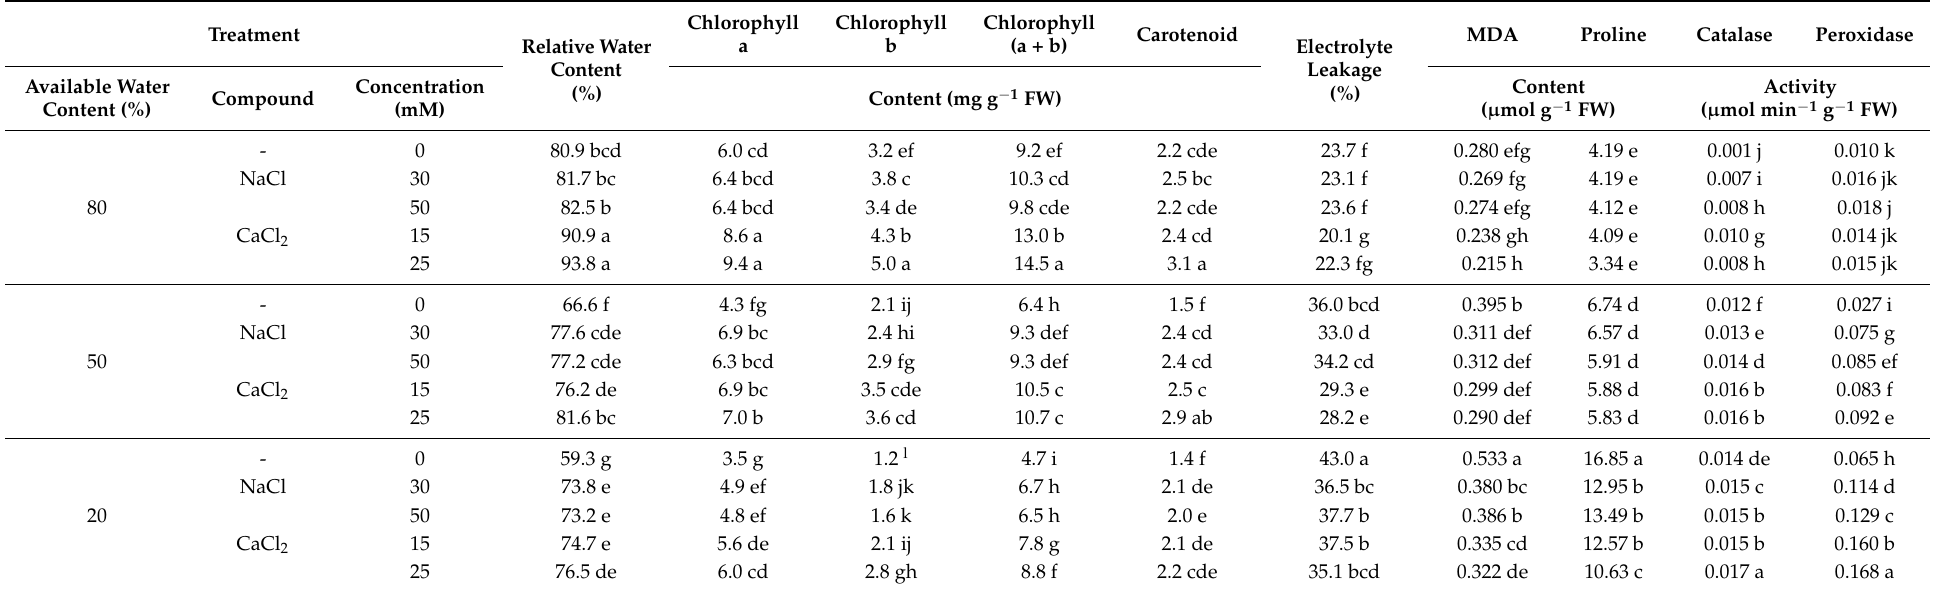
Table 5. Relative water content, electrolyte leakage, content of chlorophyll, carotenoids, malondialdehyde and proline as well as peroxidase and ascorbate peroxidase activity of periwinkle cv. ‘Pacifica XP Really Red’ plants initially receiving NaCl (0, 30 and 50 mM) or CaCl 2 (15 and 25 mM) via irrigation (five applications at 3 d intervals) and subsequently exposed to different watering levels (80, 50 and 20% available water content) during cultivation. At first application, plants were at the four-leaf stage. Means followed by different letters indicate significant differences ( p = 0.05; comparison in columns). Values are the mean of four replications. FW, fresh weight, MDA,